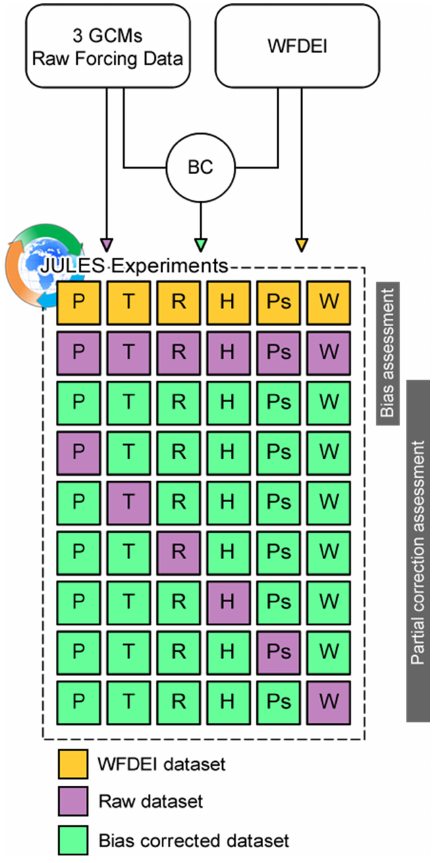
Figure 2. Graphical description of the performed